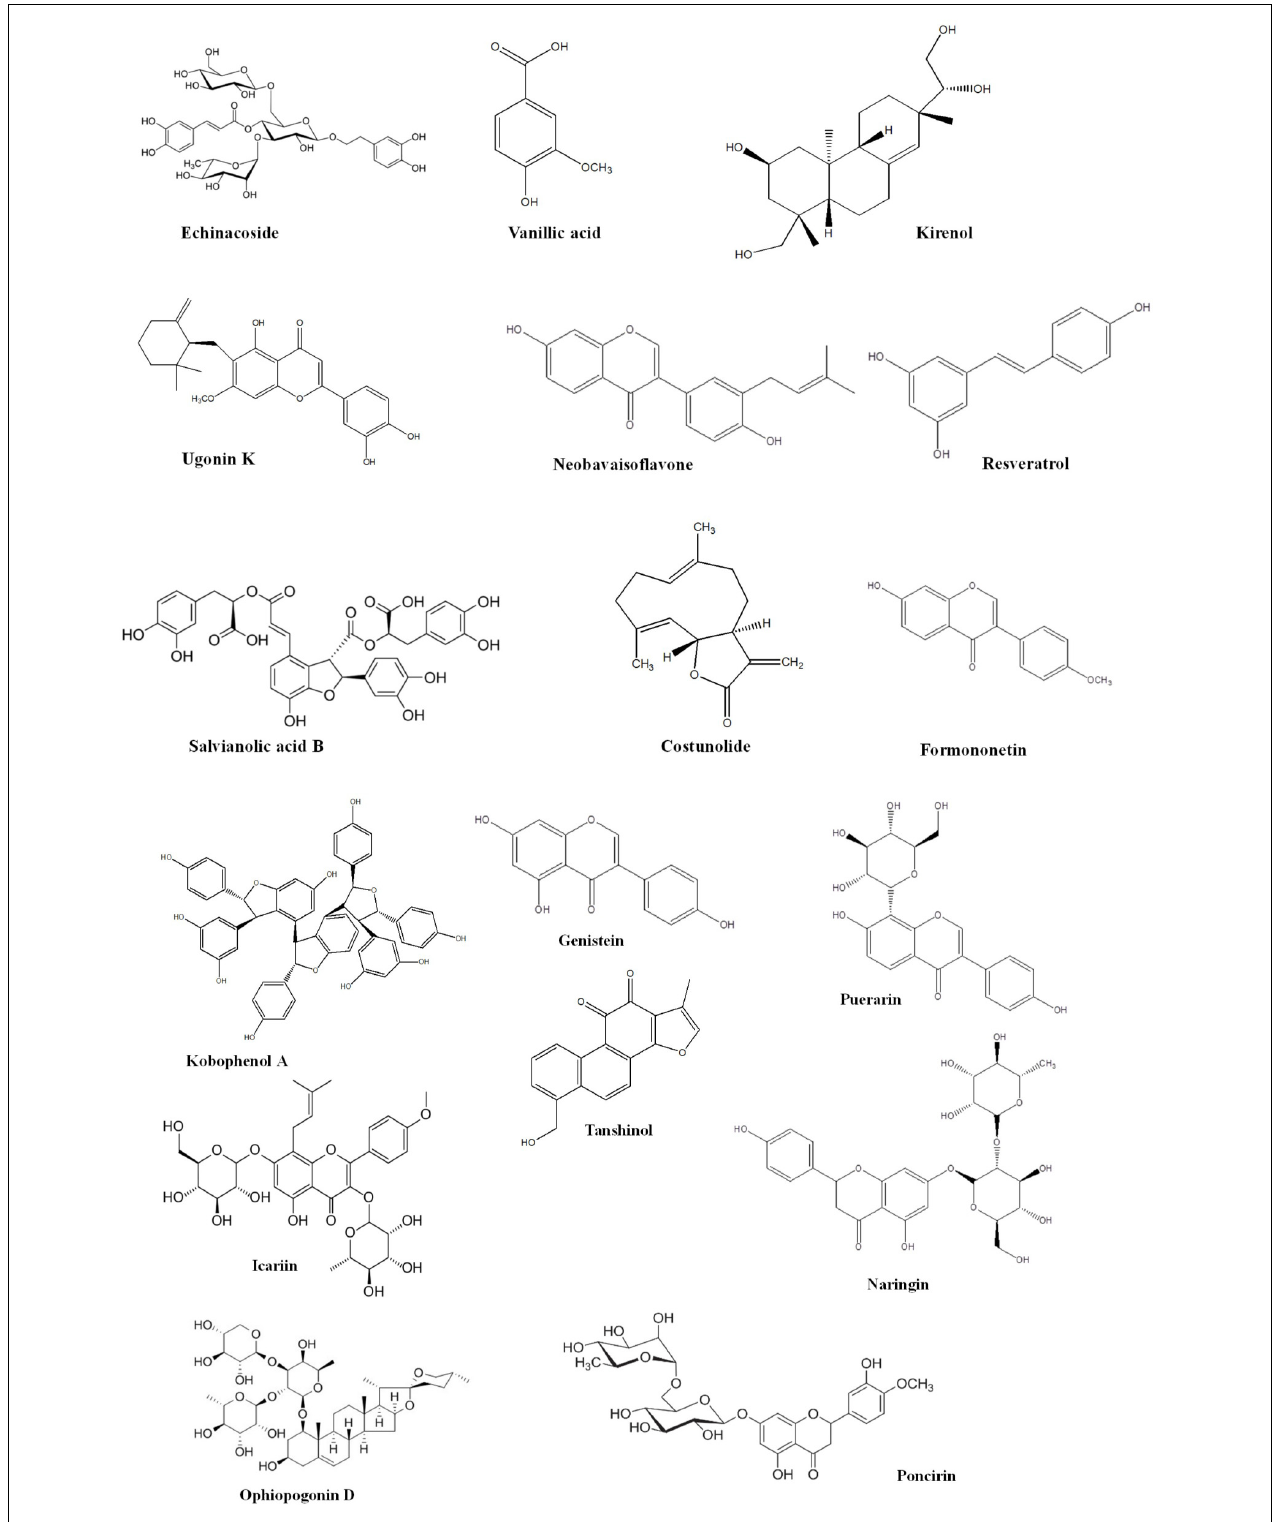
FIGURE 2 | Chemical structures of phytochemicals with antiosteoporotic activity.